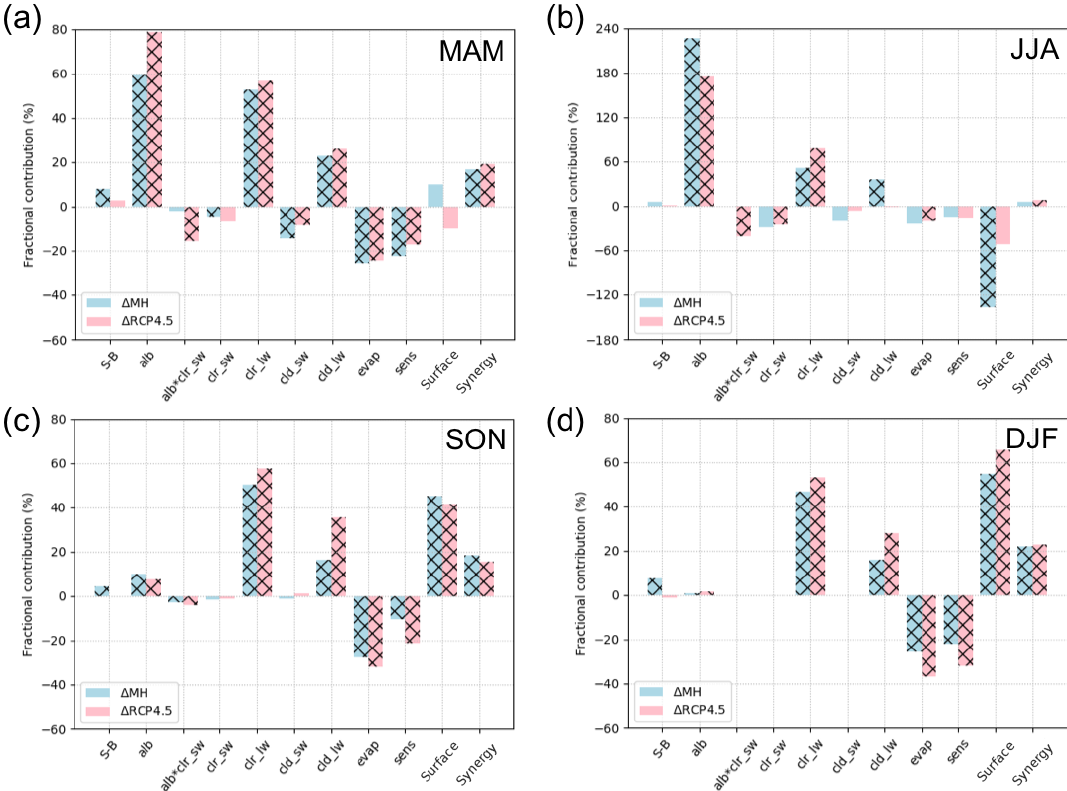
Figure 12. Fractional contribution of individual processes to the model spread in the simulated surface temperature change (%) over the ocean (north of 60 ◦ N) for (cid:49) MH and (cid:49) RCP4.5: (a) spring (March–April–May); (b) summer (June–July–August); (c) autumn (September– October–November); and (d) winter (December–January–February) means. The sum of the bar graphs in the same color for each plot adds up to 100%. The hatching indicates the contribution is statistically significant at the 10% level. All 10 models listed in Table 2 are used. See Table 3 for the interpretation of each component. Note that the vertical scale for panel (b) is 3-fold larger than those for the other